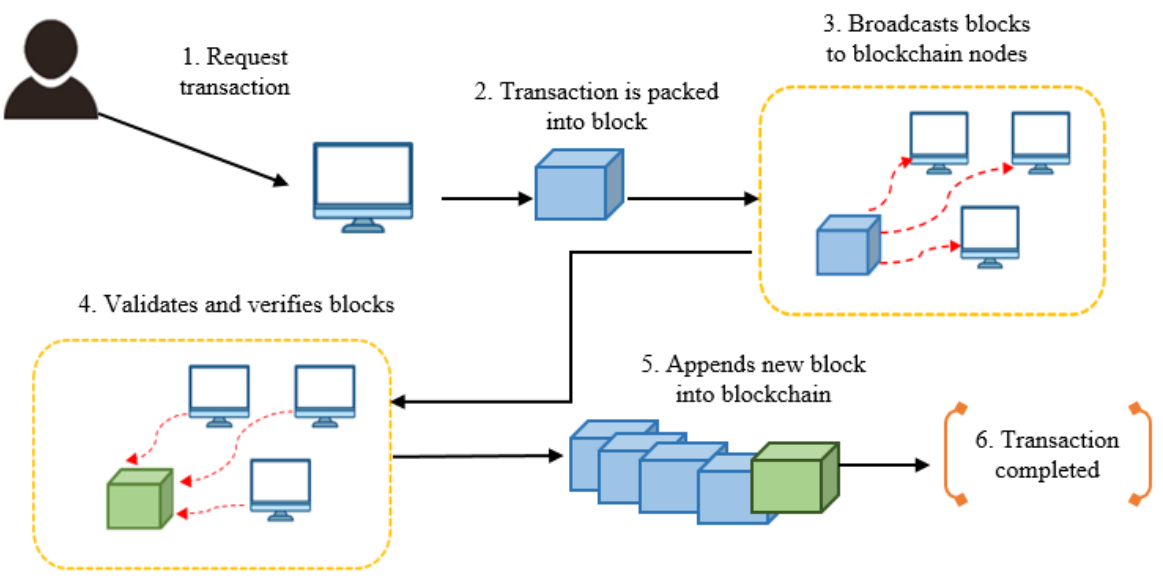
Figure 1. An overview of blockchain transaction process.